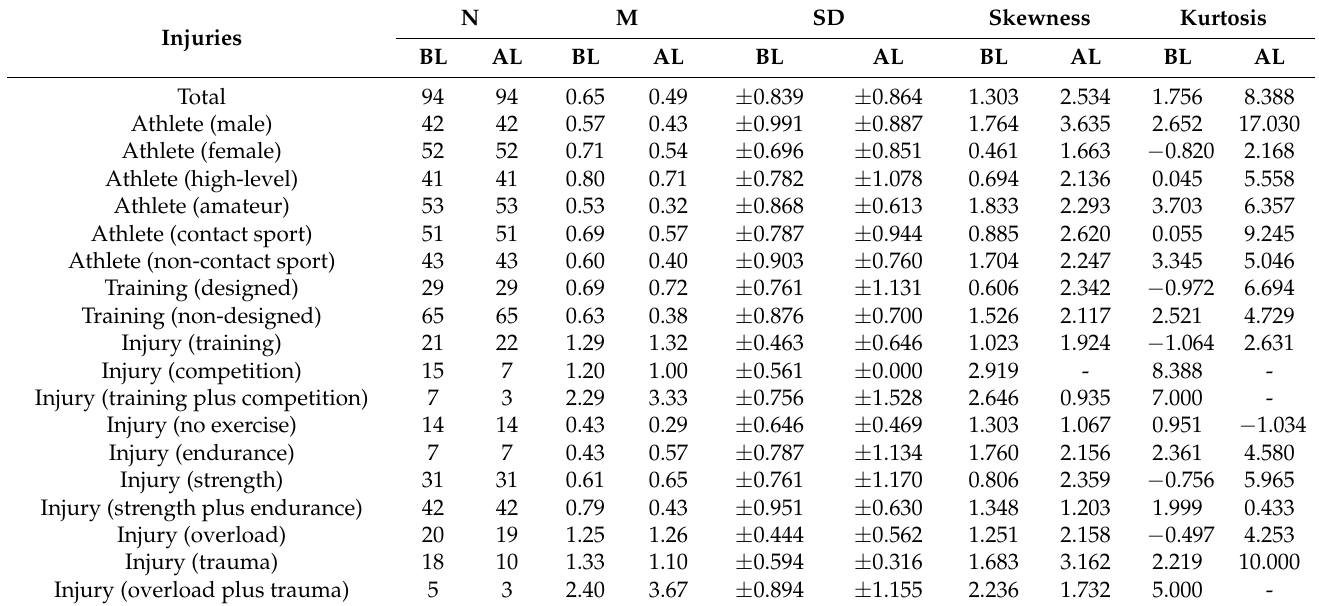
Table 2. Descriptive statistics of IRs BL and AL.